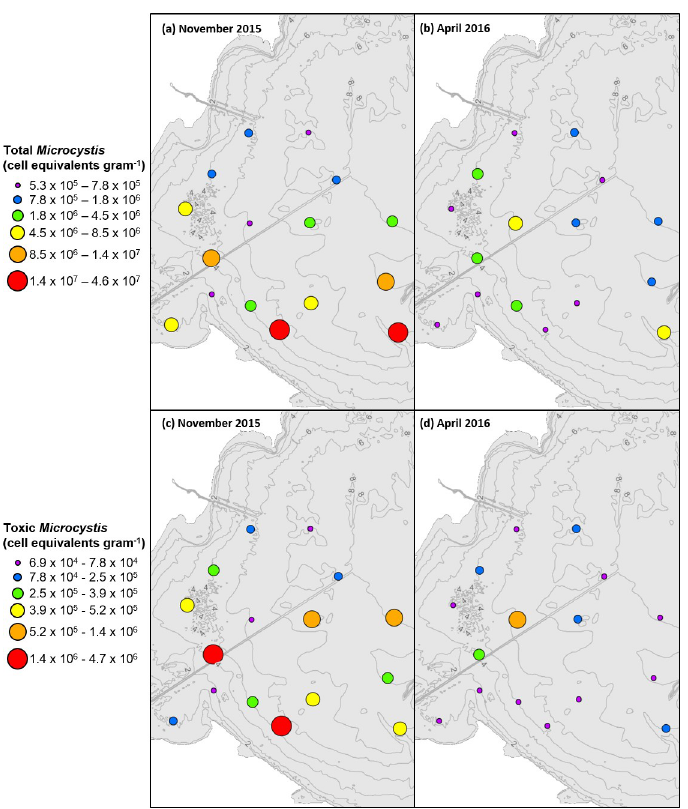
Fig 3. Total Microcystis cell equivalents in (a) November 2015 compared to (b) April 2016 per gram dry sediment and potentially-toxic Microcystis cell equivalents in (c) November 2015 and (d) April 2016 per gram dry sediment. Ranges for each category selected based on ArcGIS quantile classification of November 2015